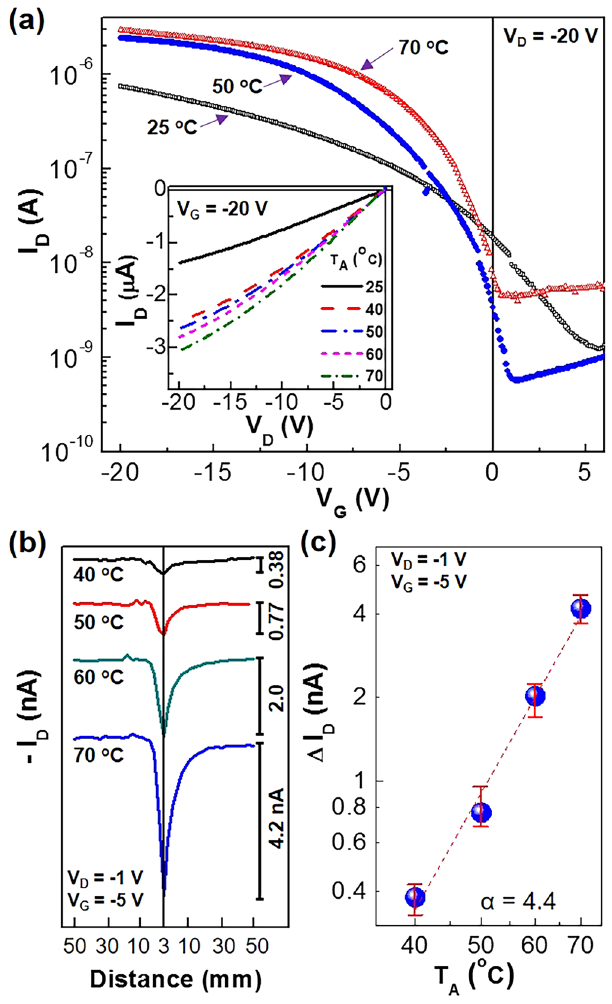
Figure 5. Thermal sensing performances under mild temperature conditions. ( a ) Transfer (inset: output) curves according to the temperature by heat sources (T A = 25~70 °C) at V D = − 20 V and V G = − 20 V. ( b ) Drain current (I D ) response according to the distance between the load-like heaters and the flexible PDLC-i-OFET devices. ( c ) Net drain current change ( Δ I D ) as a function of temperature (T A ): The dashed line was fitted with the power-law equation ( Δ I D ~ T A α ) (note that more than sixteen devices were